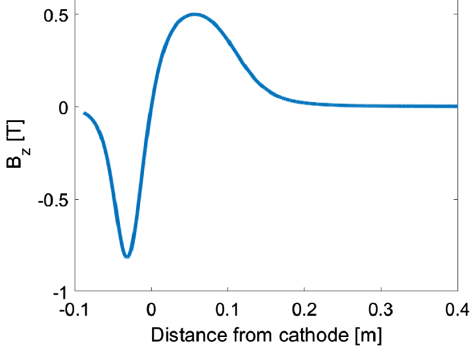
FIG. 5. B z component of the solenoid on-axis field.